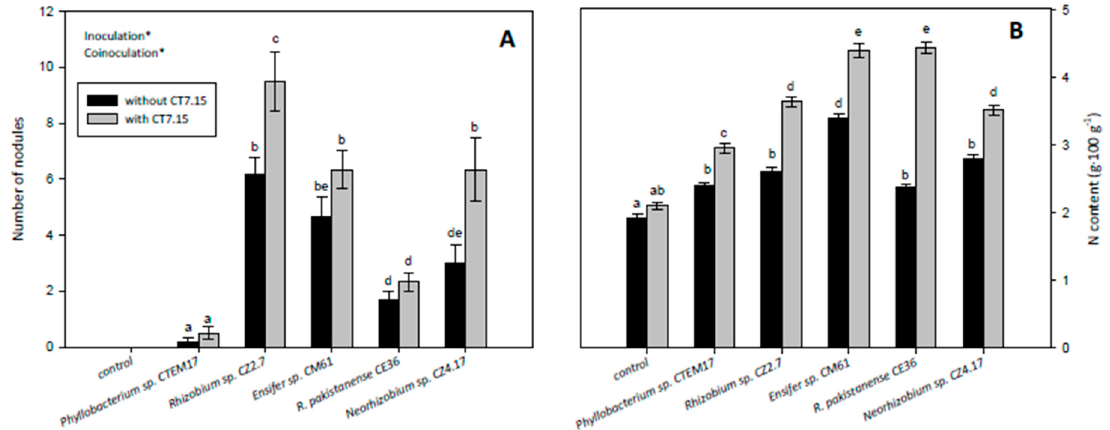
Figure 7. Number of nodules ( A ) in Calicotome villosa and nitrogen content ( B ) in randomly selected leaves of Calicotome villosa in response to inoculation with different rhizobia ( Phyllobacterium sp. CTEM17, Rhizobium sp. CZ2.7, Ensifer sp. CM61, R. pakistanense CE36 and Neorhizobium sp. CZ4.17) in absence and presence of strain CT7.15 as co-inoculant for 5 months. Values represent mean ± SE, n = 6. Different letters indicate means that are significantly different from each other (GLM, inoculation × co-inoculation; LSD test, p < 0.05). Inoculation, co-inoculation or inoculation × co-inoculation in the corner of the panels indicate main or interaction significant effects ( ∗ p < 0.001).